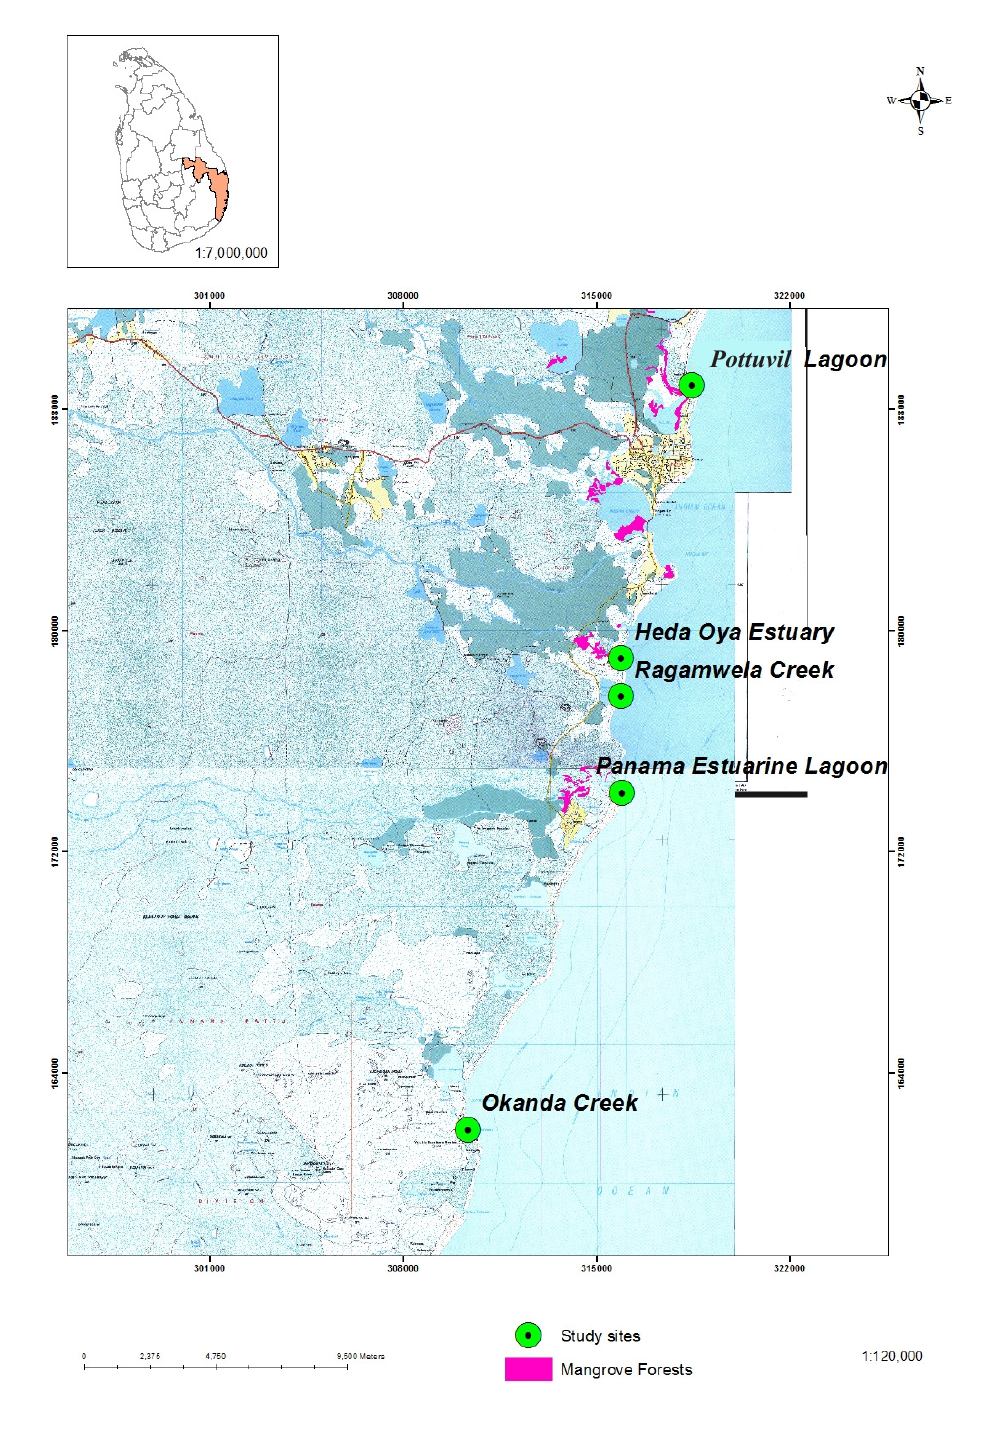
Figure 1: Location of the study sites (Modified from Survey Dept. Map).